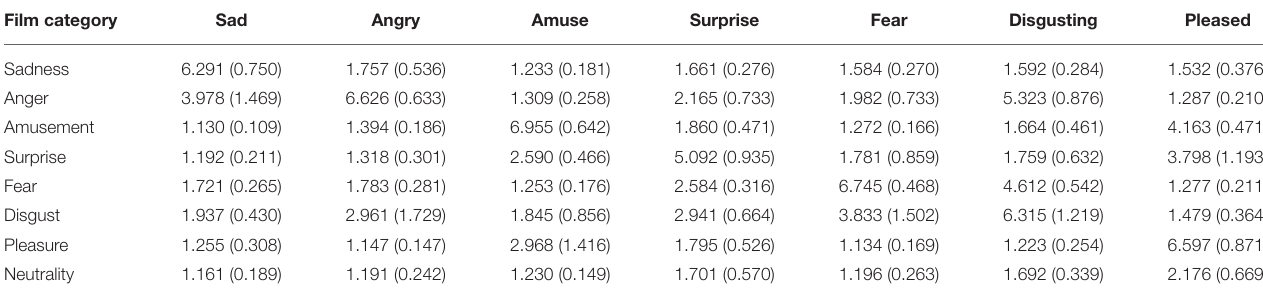
TABLE 3 | Ratings of target emotion per category, mean ( SD ).